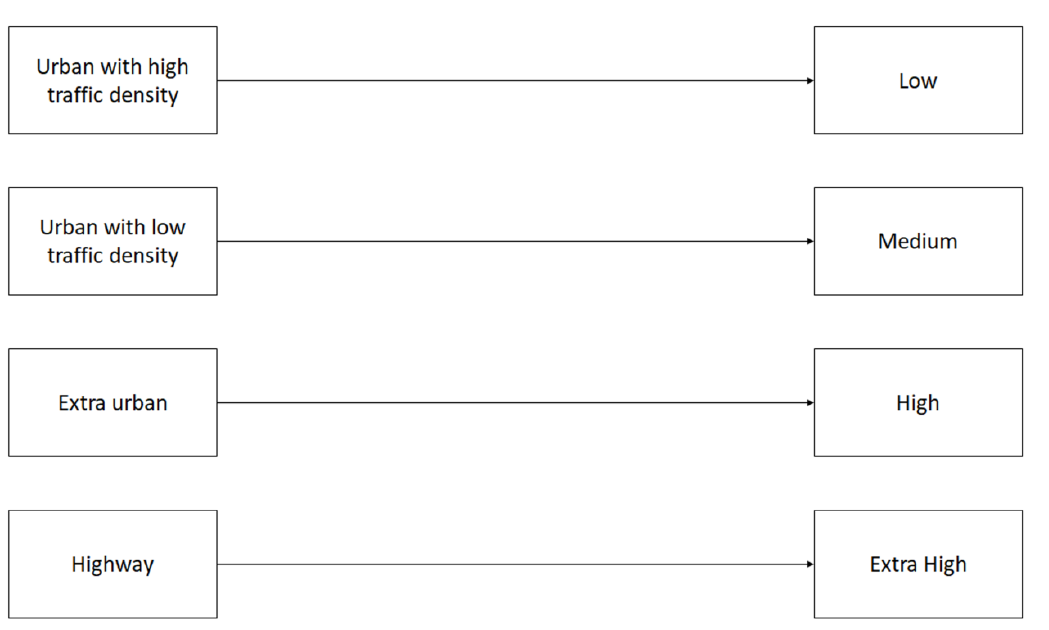
Figure 18. WLTC cycle for class 3b vehicles.